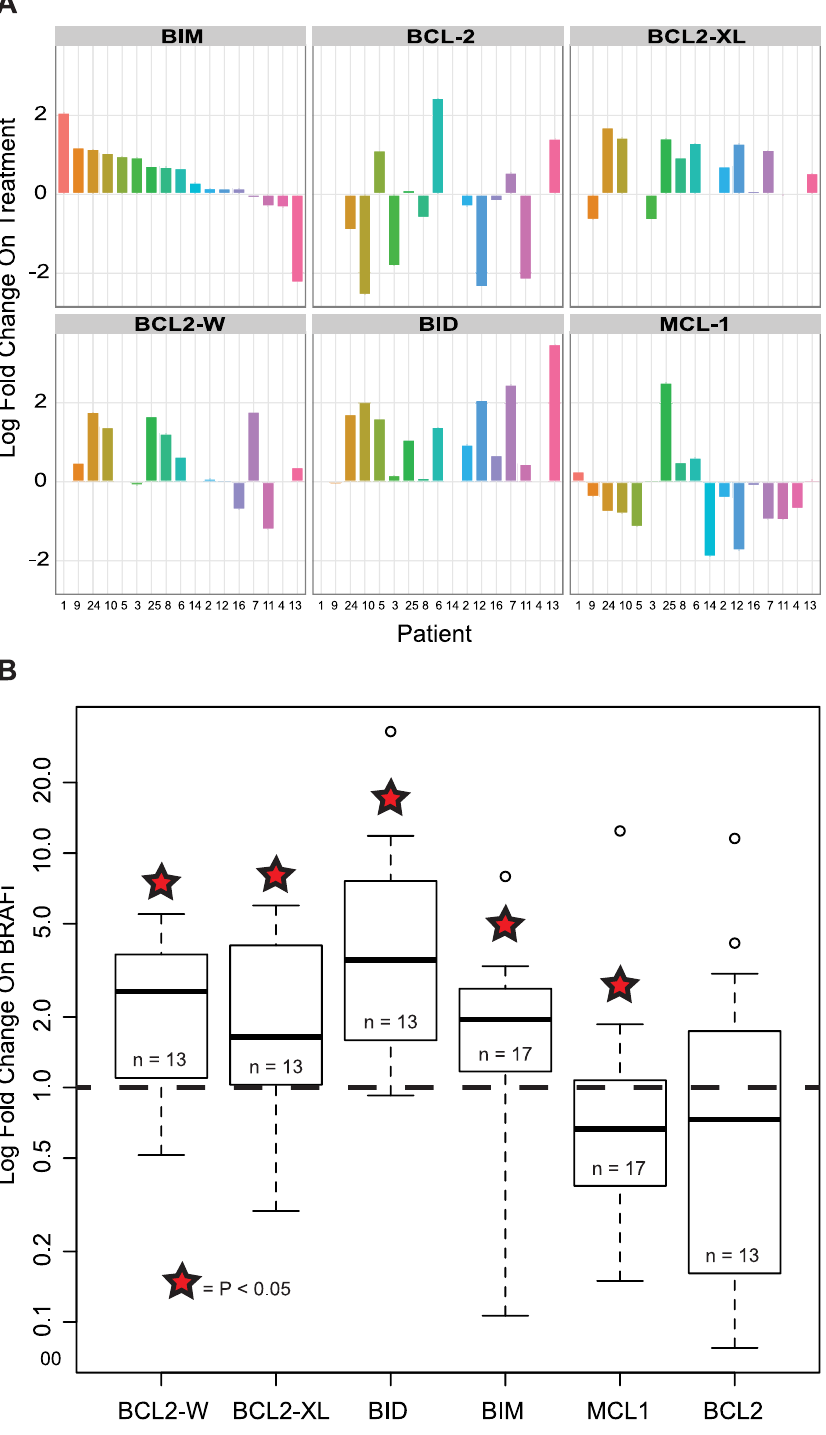
Figure 2. BRAF inhibition is associated with changes in BCL2 family member expression in tumors of patients with metastatic melanoma. mRNA levels of BIM , BCL2-XL , BCL2-W , BID increased in patients with metastatic melanoma undergoing treatment with a selective inhibitor of BRAF V600E while mRNA levels of MCL-1 decreased; BCL2 levels did not change significantly across patients. ( A ) mRNA expression levels of each gene from pre and on treatment biopsies from each patient were quantified by real-time PCR and are plotted as log fold change. Each number along the x-axis indicates an individual patient identifier, the y-axis indicates the mRNA level changes of BCL-2 family members for each patient. ( B ) Changes in mRNA expression levels across patients 10–14 days after initiation of BRAFi are plotted on a log scale as fold change from pre-treatment levels using box and whisker plots (*=P # 0.05).